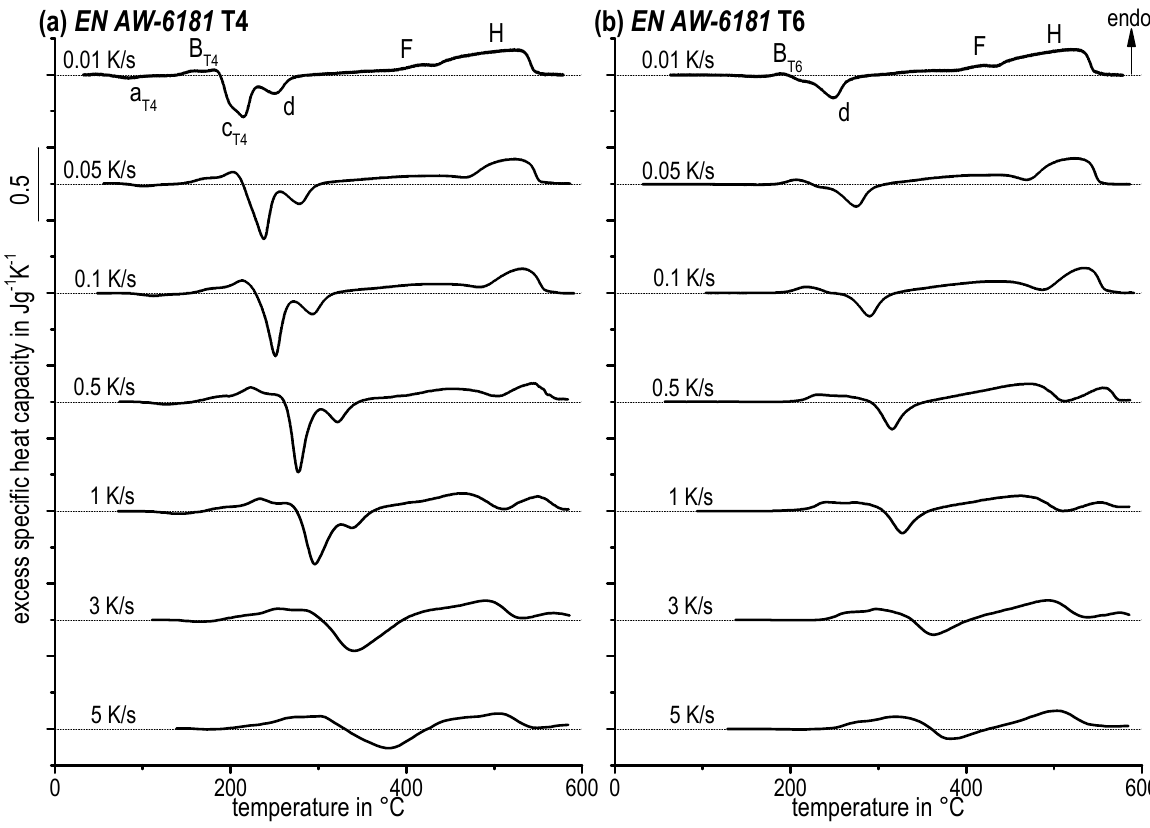
Figure 8. Continuous heating curves for EN AW-6181 with ( a ) T4 and ( b ) T6 initial